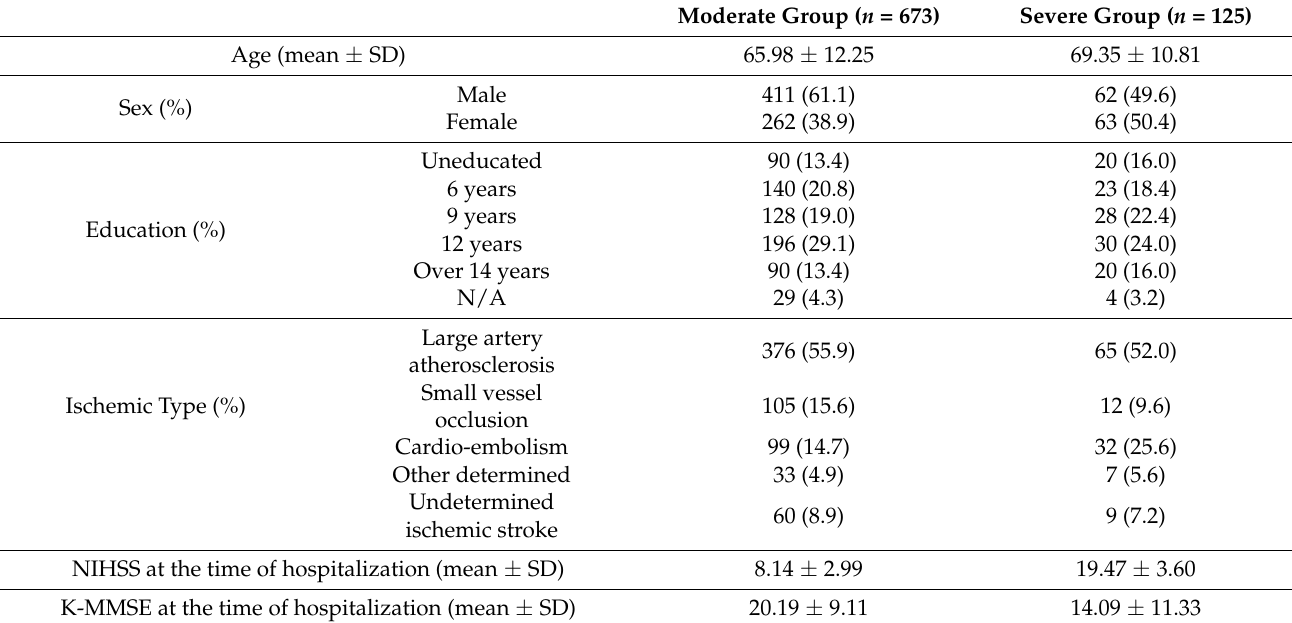
Table 1. Baseline characteristics of study population according to the severity.